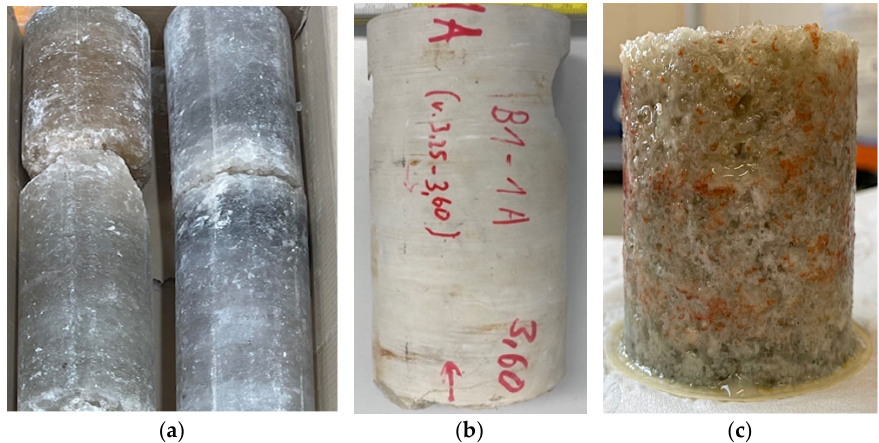
Figure 7. Core samples and bulk model after a filtration experiment. ( a ) Salt core from a brine-pro- ducing horizon; ( b ) carbonate core; and ( c ) general view of the bulk model after pumping the block- ing